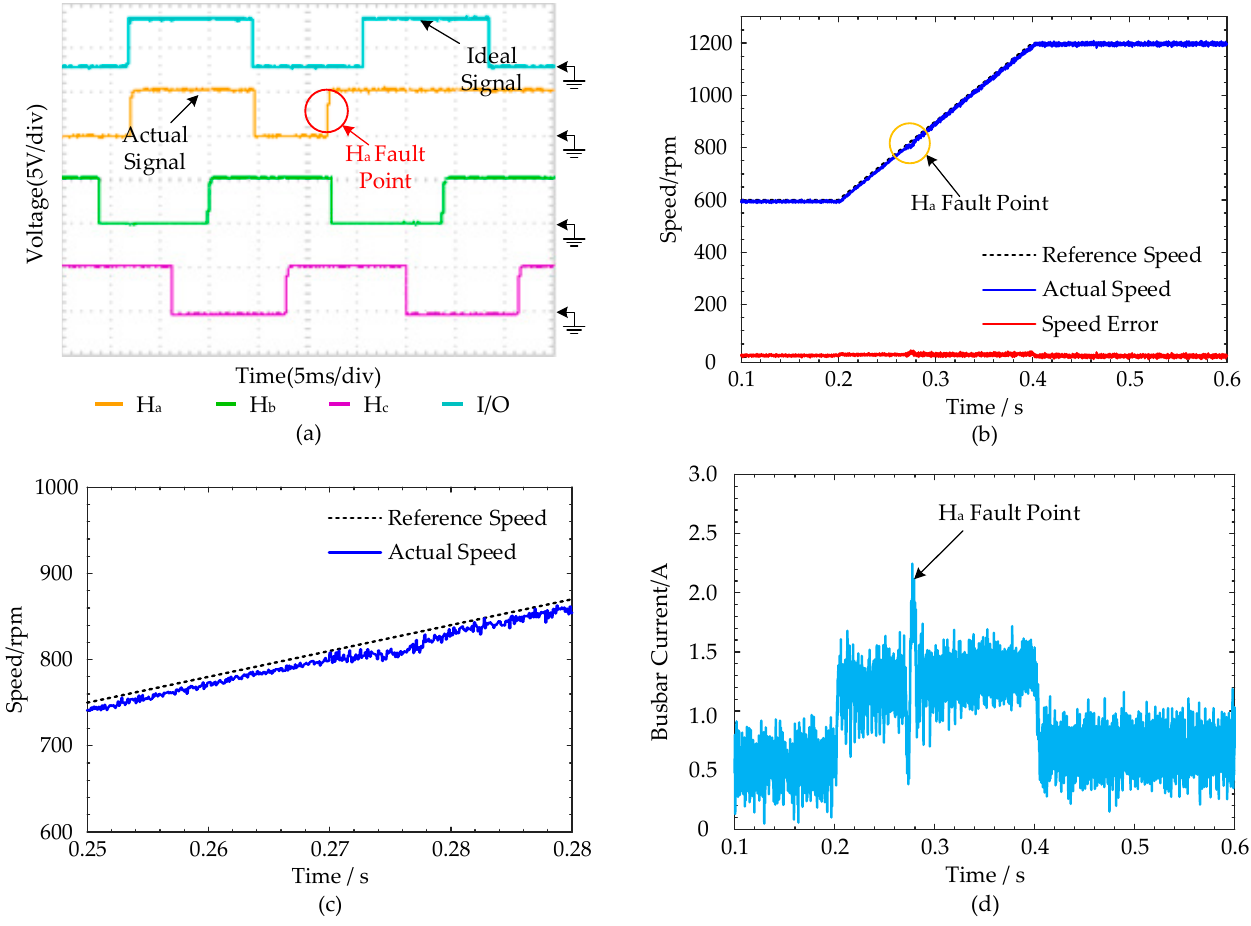
Figure 16. Single Hall fault-tolerant control experimental results: ( a ) The Hall signal curves of the motor; ( b ) the speed curves of the motor; ( c ) the detail speed curves at the fault point; ( d ) the busbar current of the motor.